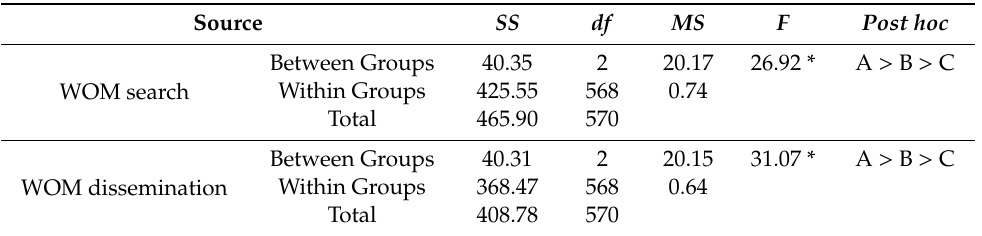
Table 4. Variance analysis of di ff erent levels of understanding in WOM.